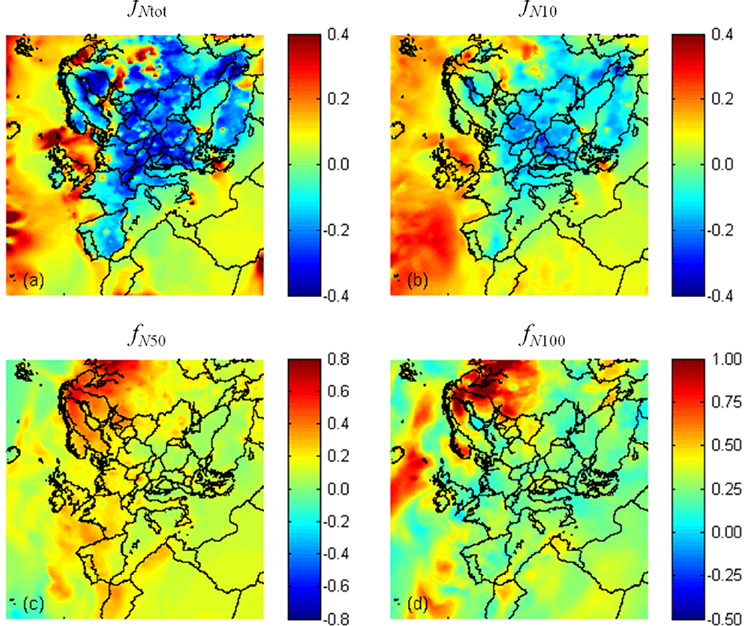
Figure 3. Ground-level average fractional increase ( f N during 5 June–8 July for (a) all particles ( f N scales are